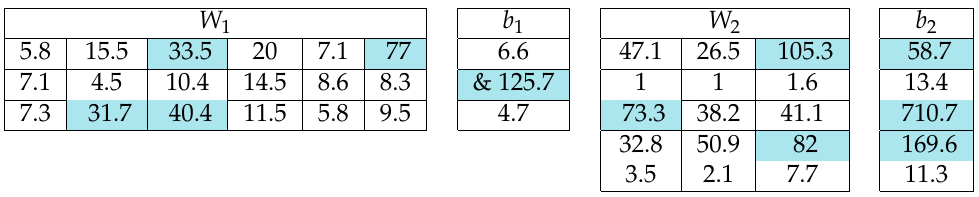
Table 4. Coefficients of variation (in %) of the estimated weights and biases—colored boxes are removed synaptic connections or biases.